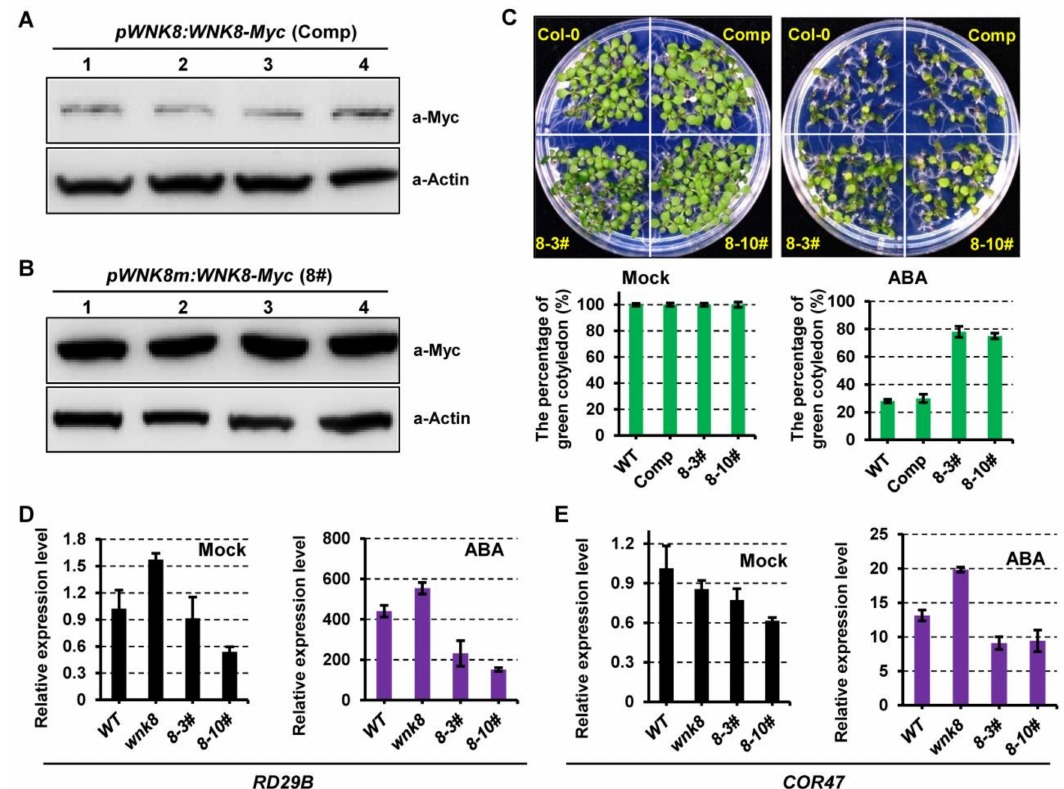
Figure 5. ABA sensitivity is altered under abnormal expression of WNK8. ( A , B ) The protein accumulation analysis of WNK8 in transgenic lines. Total proteins were extracted from the individual stable transgenic seedlings transformed with pWNK8:WNK8 ( A ) or pWNK8m:WNK8 ( B ), and further probed with antibodies α –Myc and α –Actin. ( C ) Photographs of seedlings grown on different media in the absence or presence of ABA at day 10 after stratification. Two independent transgenic lines transformed with pWNK8m:WNK8 (8-3# and 8-10#) and the complementation of WNK8 in wnk8-1 line (Comp) were analyzed. Cotyledon greening percentages were recorded after germination for 10 days. Three independent experiments were conducted, and over 50 seeds of each genotype were applied in each replicate. The standard deviation of three replicates were indicated with error bars. ( D , E ) The expression analysis of ABA response genes in different genotypes. The expression profiles of ABA-signaling-related genes RD29B ( D ) and COR47 ( E ) were examined in one-week-old seedlings in the absence or presence of 50 µ M ABA for 3 h. The transcriptional levels of ABA response genes were normalized to that of Actin2